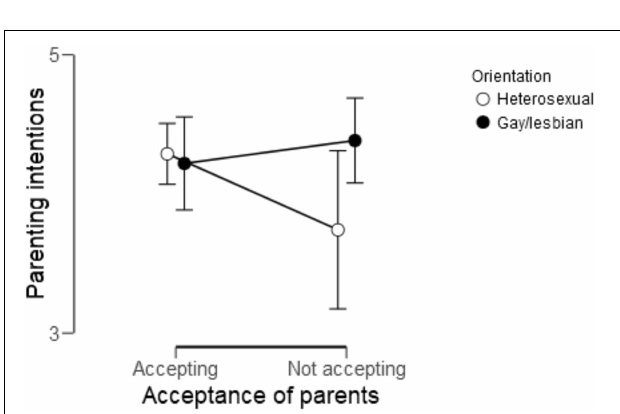
FIGURE 5 | Regression plot showing the relationship between the acceptance of parents regarding potential future parenthood and the strength of parenting intentions among gay men and lesbian women vs. heterosexual men and women. Points represent group averages, n = 287. Acceptance of parents was dummy recoded with responses of 1 thru 4 to 0 ( not accepting ) and 5 to 1 ( accepting ). For the strength of parenting intentions, responses were on 6-point Likert scale with higher scores indicating a stronger intent to become a